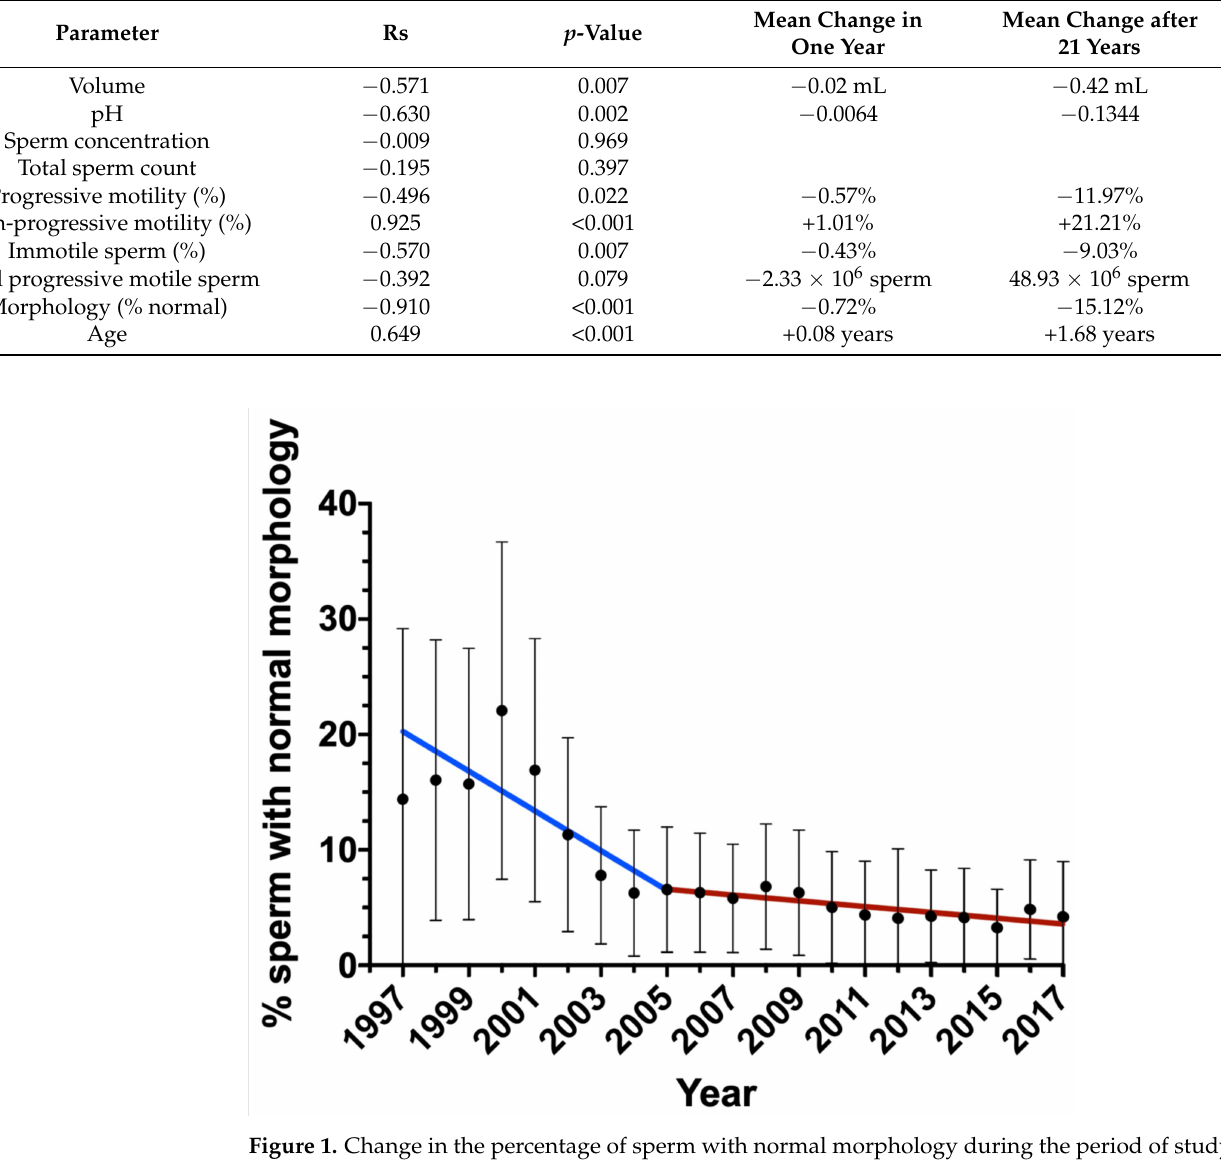
Table 2. Coefficients of correlation (Rs) between time and yearly mean of each semen variable, and changes of means in one year and after 21 years.